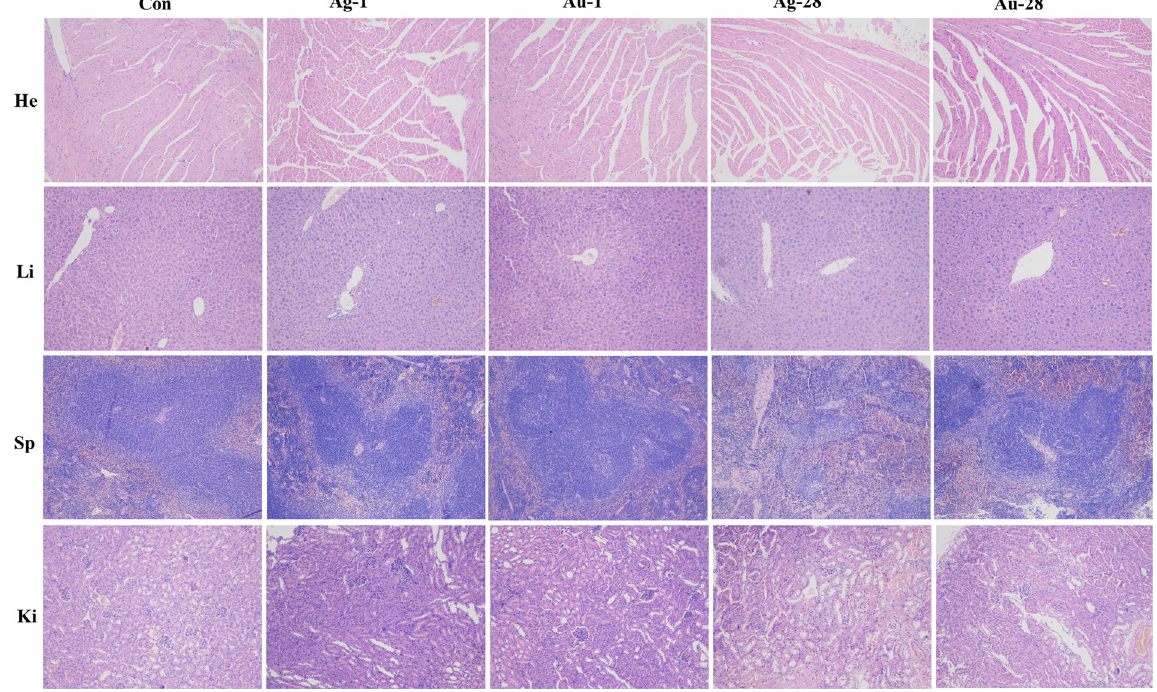
Figure 6. Histological images in treated animals exhibit no signs of toxicity. Heart (He), liver (Li), spleen (Sp), and kidney (Ki), from animals treated with AgNPs or AuNPs and control. Ag-1, Ag-28, Au-1, Au-28 represent the organs were collected from mice at 1 and 28 dpi, respectively. n = 5.